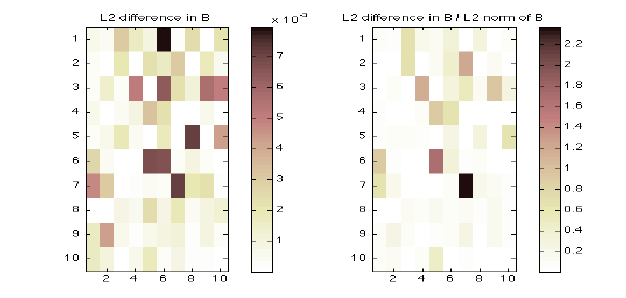
Figure 2: Heatmap of L 2 differences (absolute and relative) between entries of true J and estimated J .